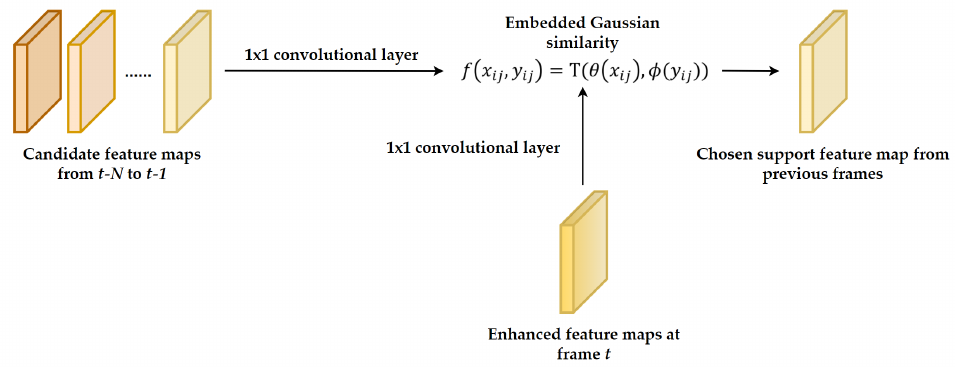
Figure 5. Structure of the supporting frame selection